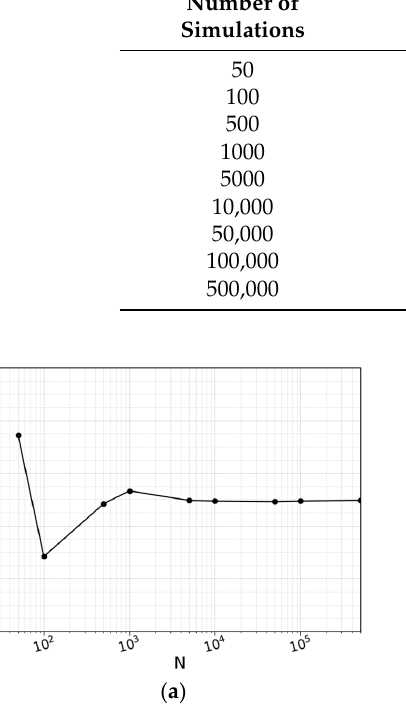
Figure 11. Convergence of ( a ) the mean value and ( b ) the standard deviation.